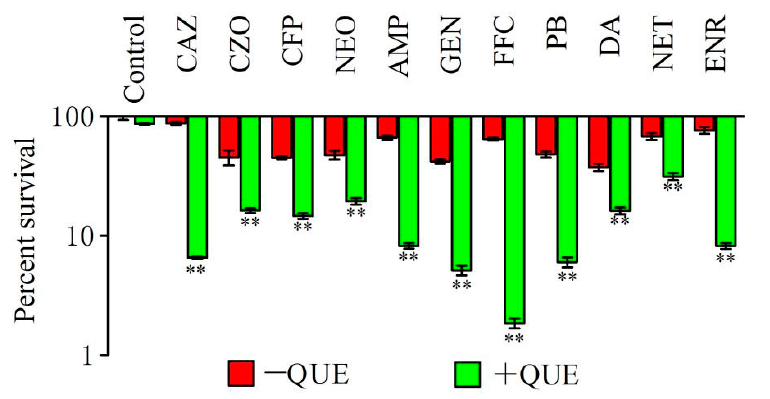
Figure 1. Percent survival of A. hydrophila in the presence or absence of quercetin plus the indicated antimicrobial agents. CAZ, ceftazidime, 0.04 μ g/mL; CZO, cefazolin, 0.625 μ g/mL; CFP, cefoperazone, 0.625 μ g/mL; NEO, neomycin, 0.625 μ g/mL; AMP, ampicillin, 250 μ g/mL; GEN, gentamicin, 0.625 μ g/mL; FFC, florfenicol, 0.156 μ g/mL; PB, polymyxin B, 25 μ g/mL; DA, clindamycin, 25 μ g/mL; NET, netilmicin, 0.25 μ g/mL and ENR, enrofloxacin, 1 μ g/mL; QUE, quercetin. ** p < 0.01.